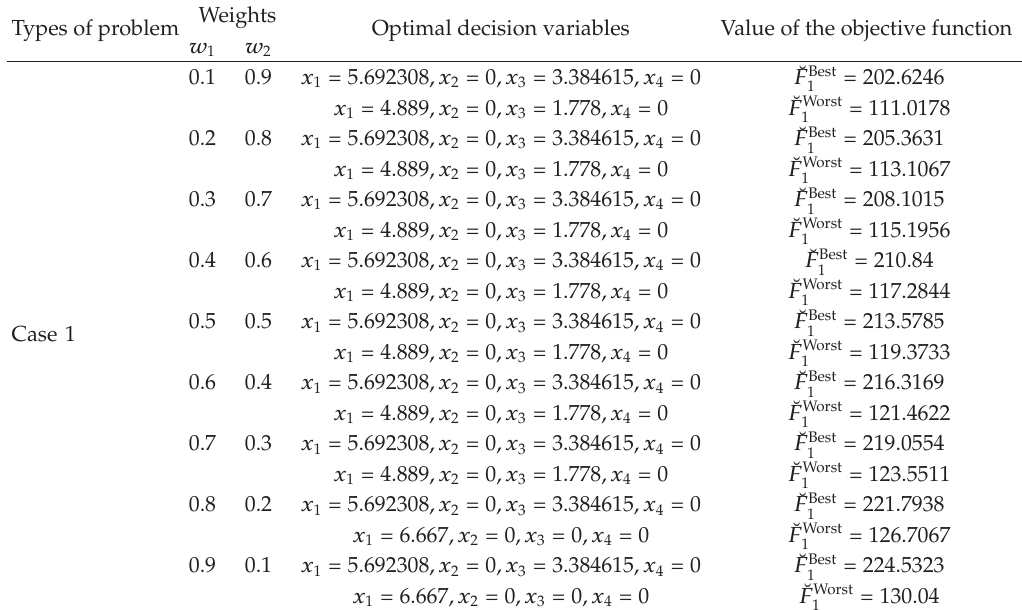
Table 1: Optimal solution for Case